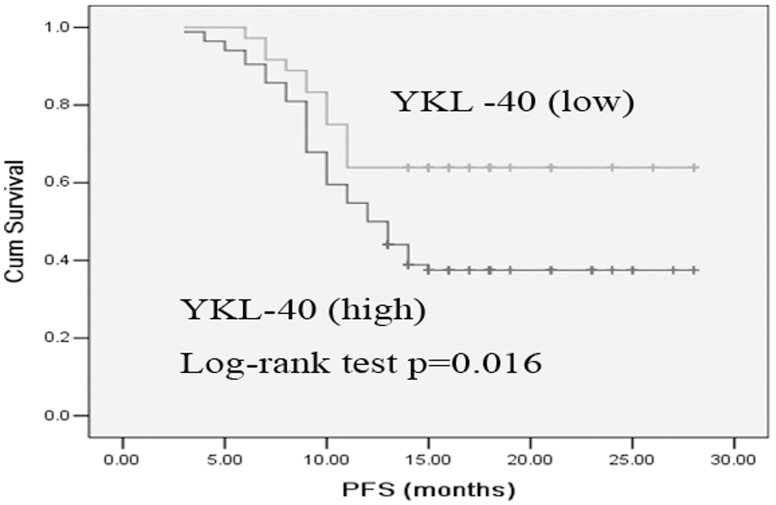
Kaplan-Meier curve comparing PFS of SCLC patients with high serum YKL-40 versus those with low serum YKL-40.Log-rank test determined that the PFS in low serum YKL-40 group was significantly longer than those of the high serum YKL-40 group (p = 0.016).